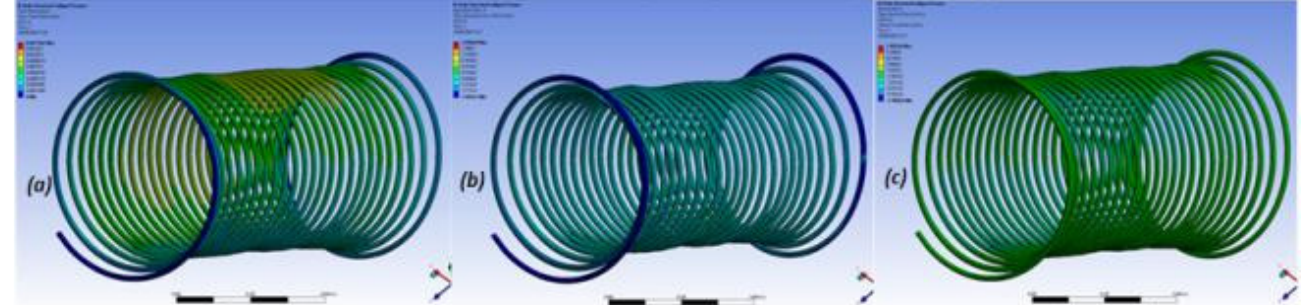
Figure 13. Collapse loading on the helical spring reinforcement under extreme conditions showing ( a ) total deformation, ( b ) equivalent von Mises stress and ( c ) normal stress (ends are free without end fittings in this case).